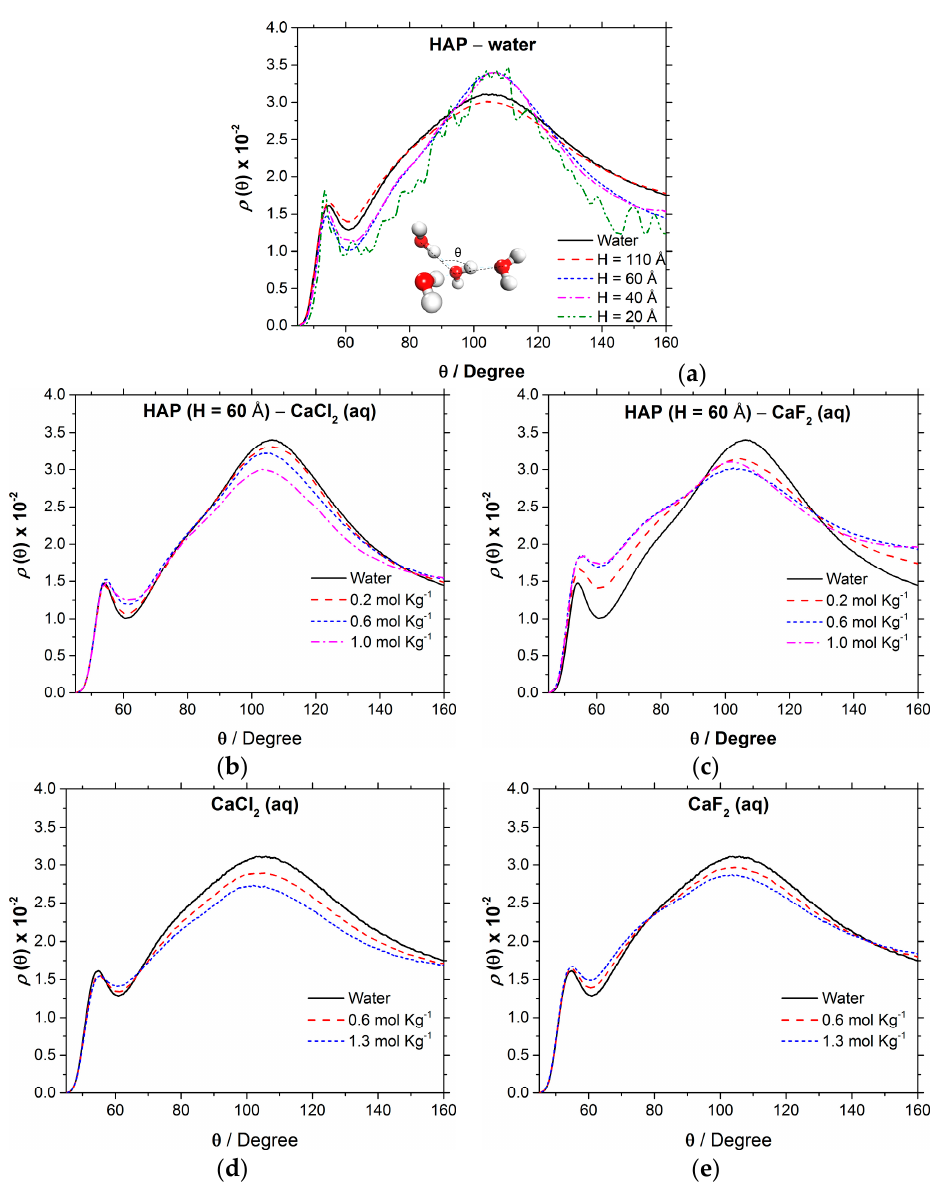
Figure 3. Angular distribution functions of the O–O–O ( ρ ( θ )) of water molecules. ( a ) Bulk water and HAP nanopores–water (20 Å ≤ H ≤ 110 Å). ( b ) HAP nanopore (H = 60 Å)–CaCl 2 solutions. ( c ) HAP nanopore (H = 60 Å)–CaF 2 solutions. ( d ) Bulk water and aqueous CaCl 2 solutions. ( e ) Bulk water and aqueous CaF 2 solutions.